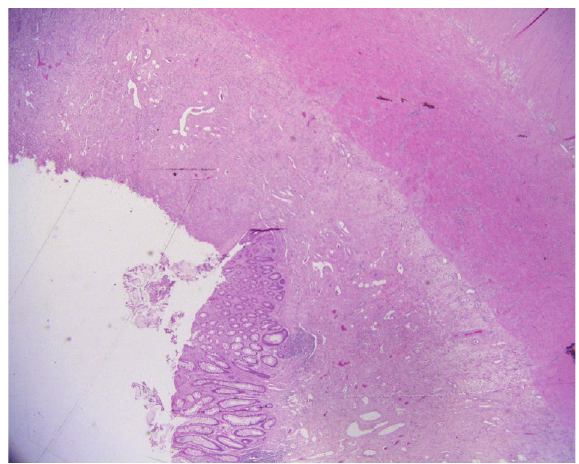
Figure 1: Idiopathic retractile sclerosing mesocolitis: inflammation of intestinal wall associated with erosion of mucosa (emathoxilyn- eosin 100x original magnification).